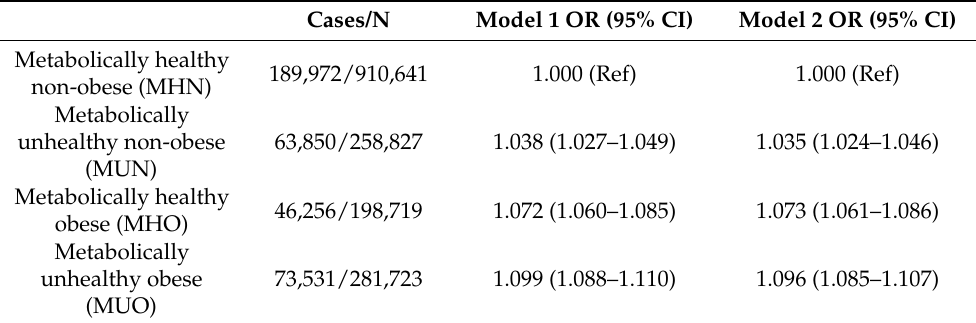
Table 4. OR (95% CI) for the relationship between metabolic health and obesity with a risk of depression over three years of follow-up (women).